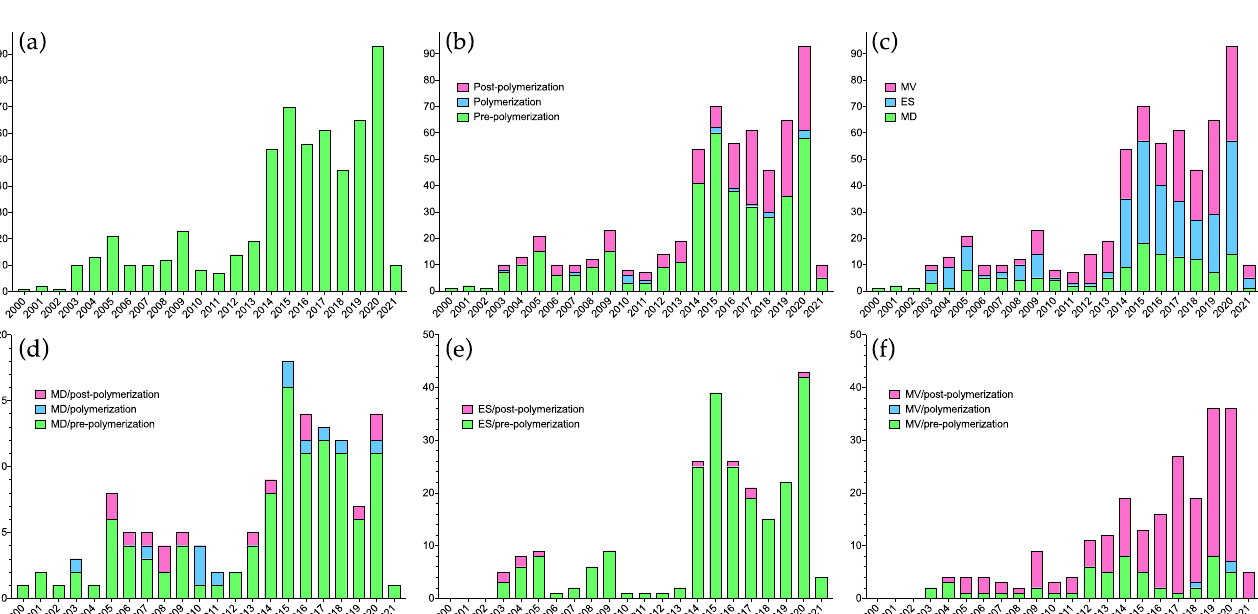
Figure 2. Number of papers published where computational methods have been applied to some aspect of molecular imprinting. ( a ) Total number of papers, ( b ) number of papers according to stage, ( c ) number of papers according to method: multivariate (MV), electronic structure (ES) or MD, ( d ) MD-based papers according to stage, ( e ) ES-based papers according to stage and ( f ) MV-based papers according to stage. Note that a number of papers fall into more than one category.